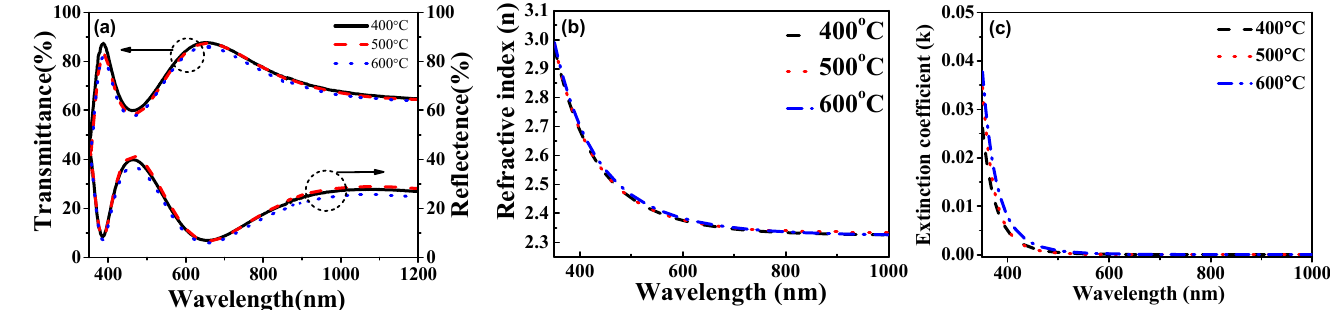
Figure 3. ( a ) Transmittance and reflection spectra, ( b ) the fitted refractive index (n) and ( c ) extinction coefficient (k) of TNO films deposited at O 2 ratio of 0.2% with various annealing temperatures as a function of wavelength.